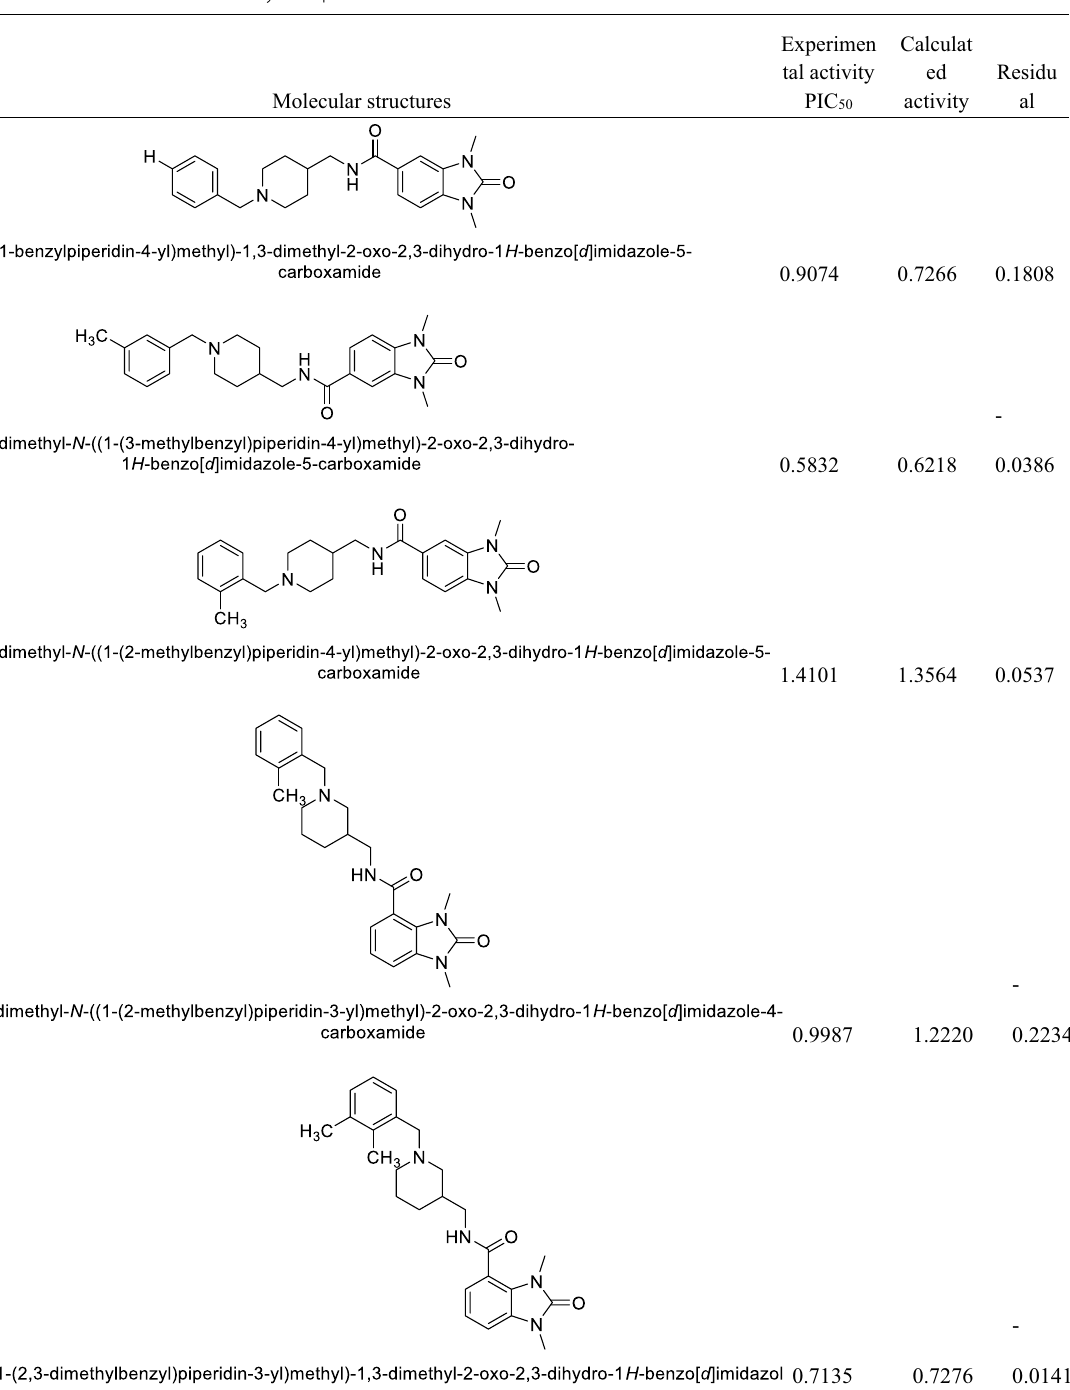
Table 1 Molecular structures of inhibitory compound